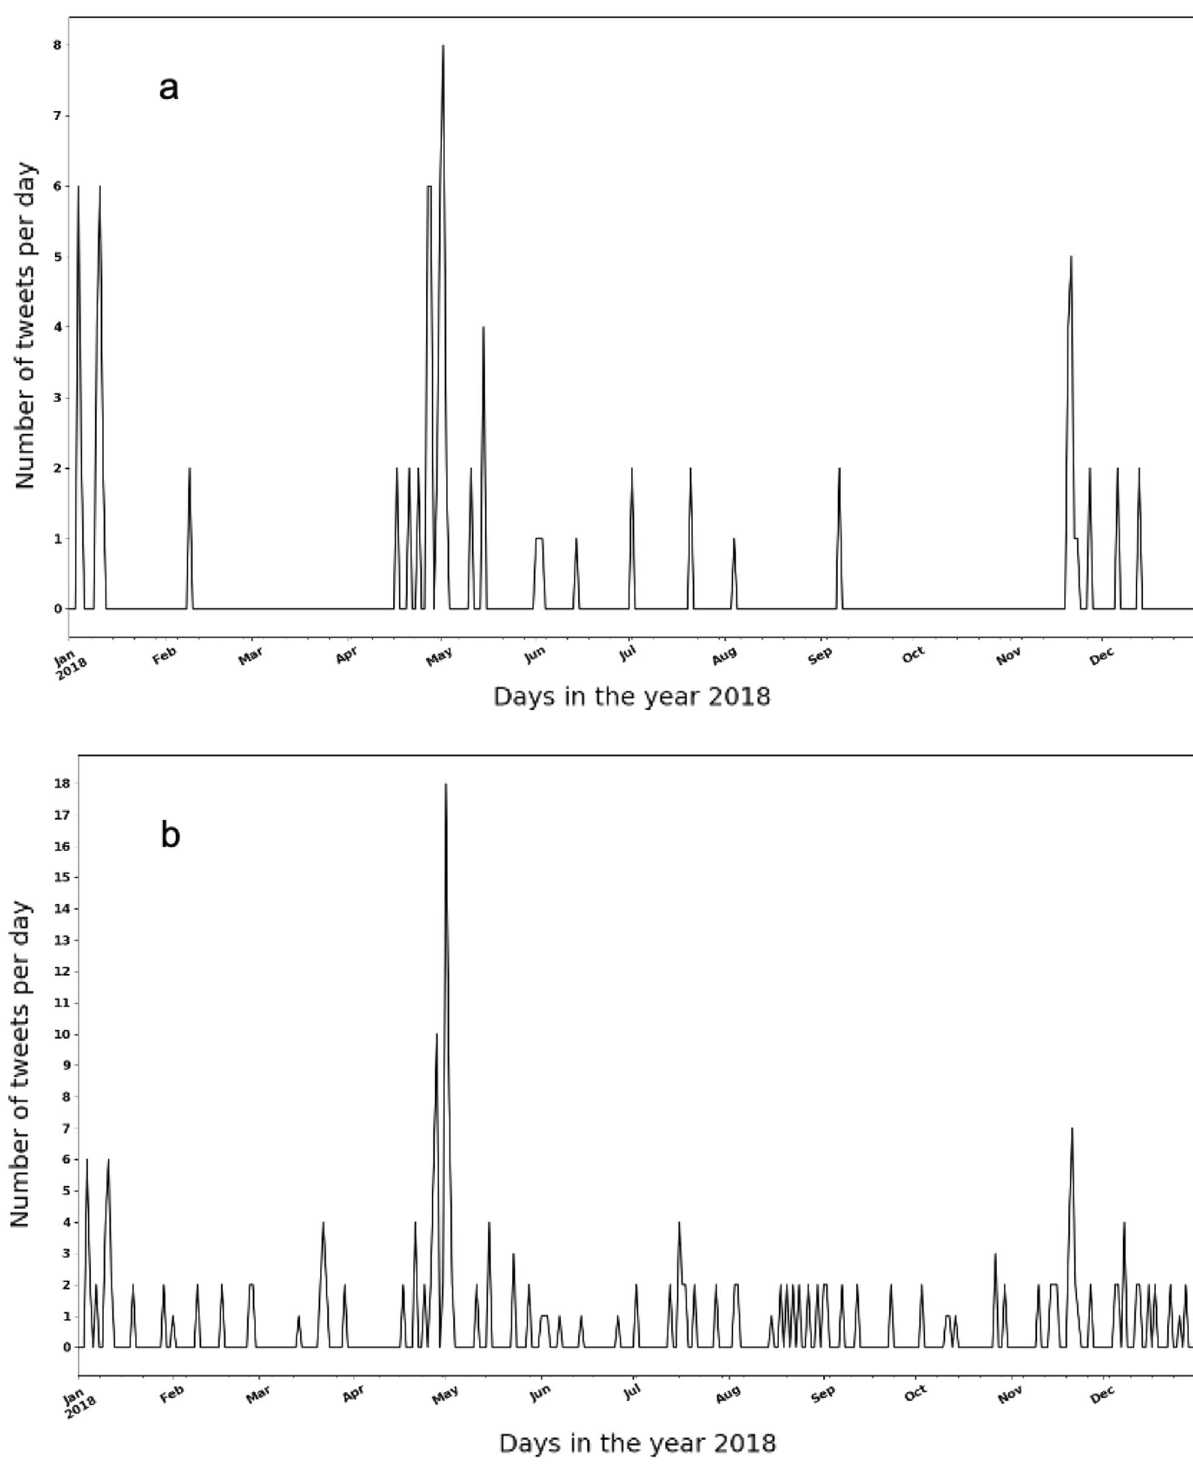
Figure 6. Number of tweets related to foodborne illness incidents in the United States ( a including “lettuce” in the tweets and b including “lettuce” or “salad” or “sandwich” in the